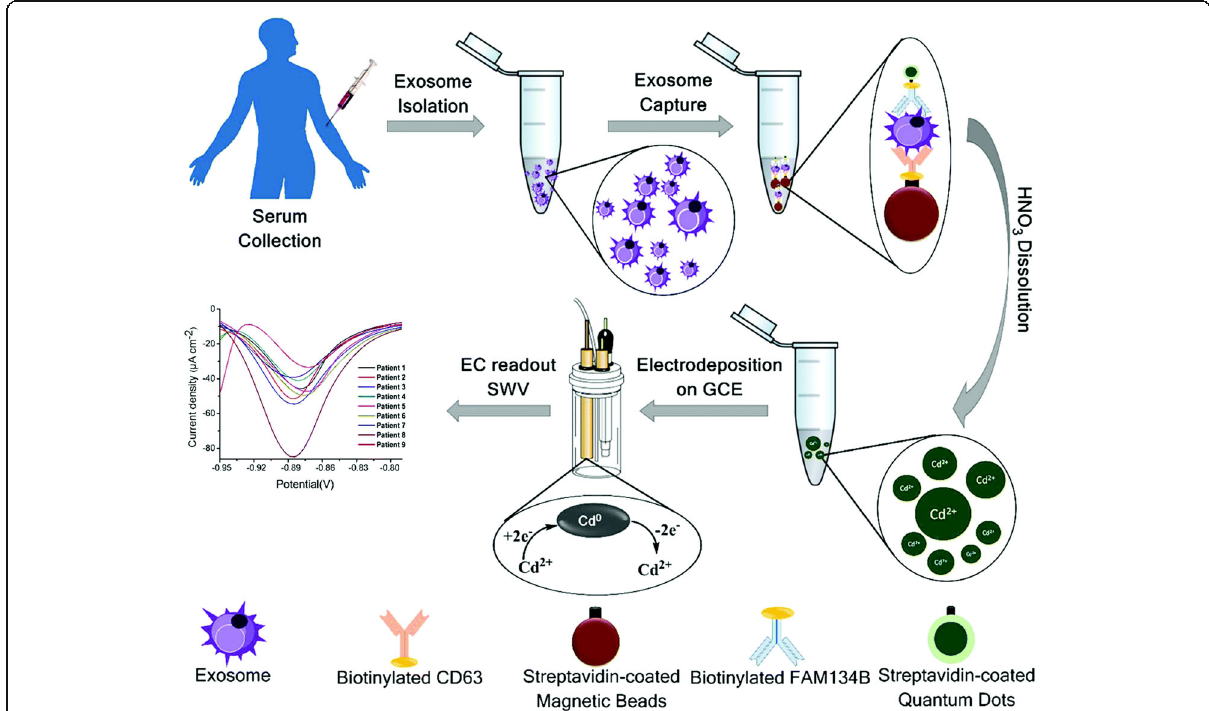
Fig. 6 The isolation and quantify method of cancer-specific exosomes based on CdSeQD [137]. Copyright© 2017, Royal Society of